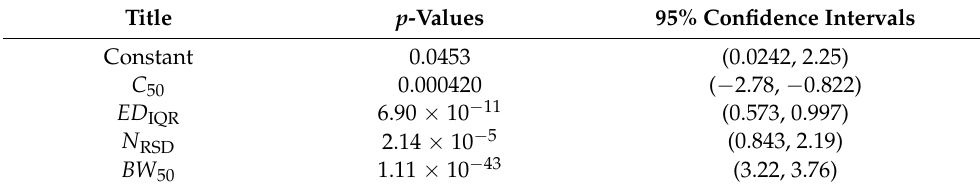
Table A1. p -values and 95% confidence intervals for the predictors used in Equation